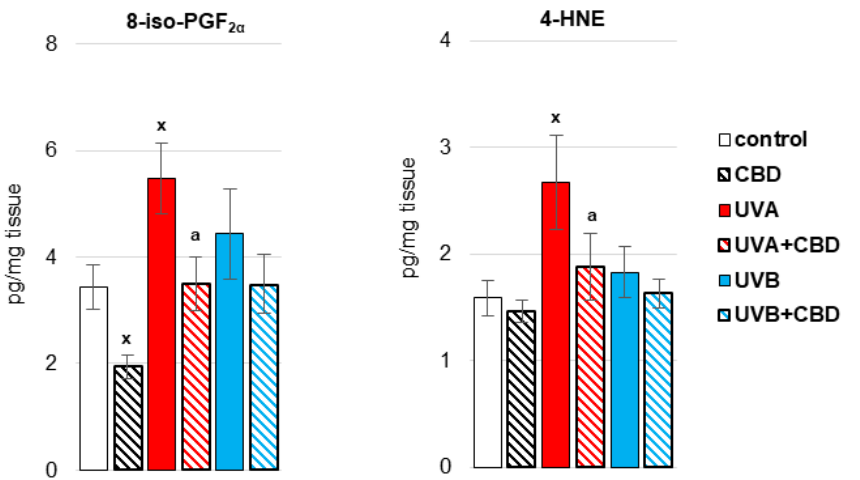
Figure 4. The level of 8-isoprostanes (8-iso-PGF 2 α ) and 4-hydroxynonenal (4-HNE) in the liver of nude rats in the following groups: treated with CBD (every 12 h) for 4 weeks; irradiated with UVA (every 48 h) and treated with CBD (every 12 h) for 4 weeks; irradiated with UVB (every 48 h) and treated with CBD (every 12 h) for 4 weeks. The mean values for six rats in each group ± SD are shown: x—differences vs. control group, p < 0.05; a—differences vs. UVA treated group, p <